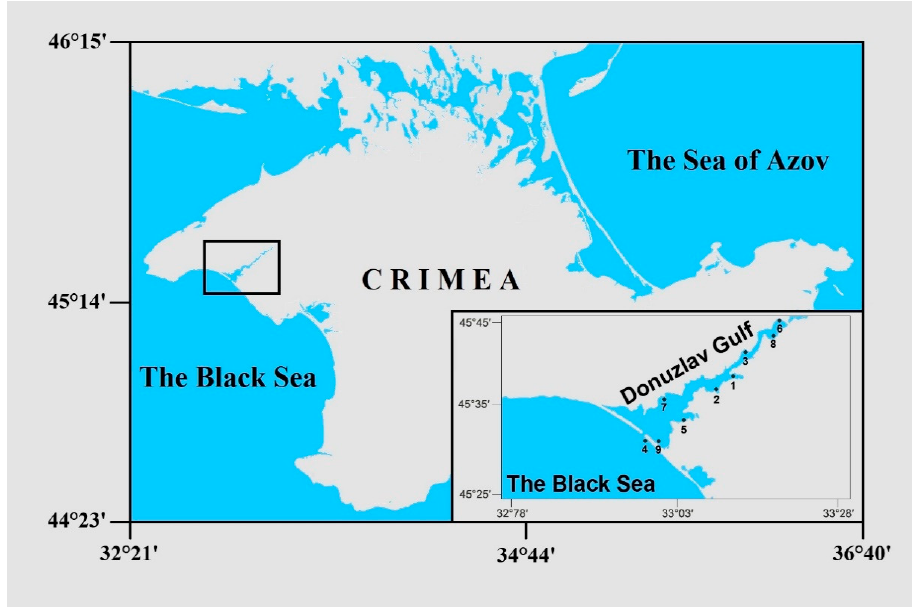
Figure 1. Crimean area of the studied diatoms—Donuzlav Gulf of the Black Sea.